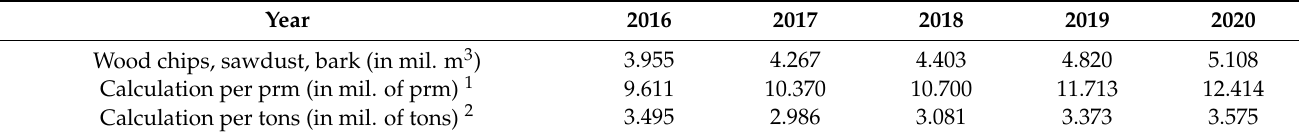
Table 5. Annual volume of forest chips produced in the Czech Republic in